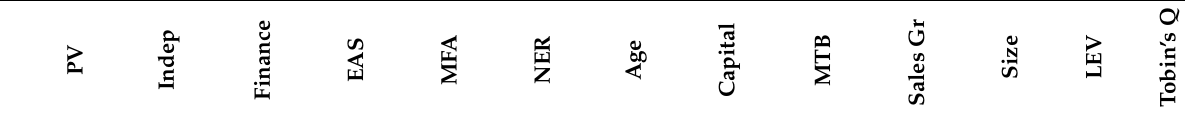
Table 3. Correlation coefficients of low-level political